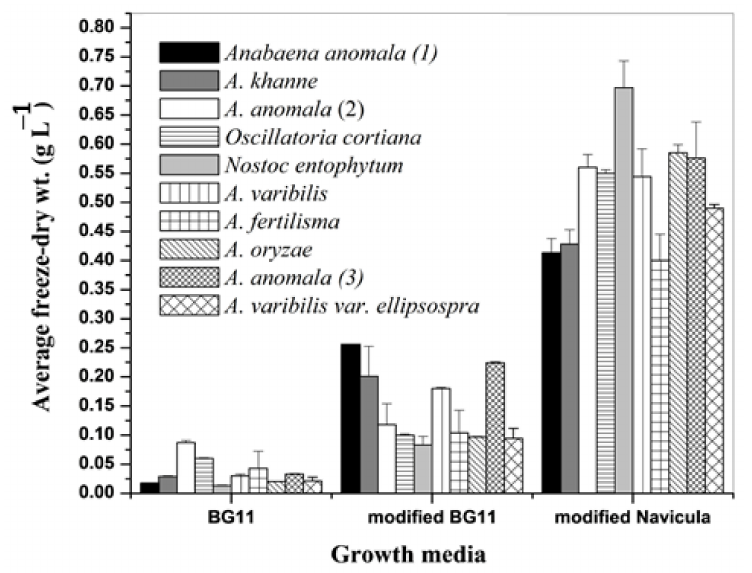
Figure 1. Average freeze-dry weight (mean of three replicates ± SD) of different species of cyanobac- teria grown on different nutrient media.